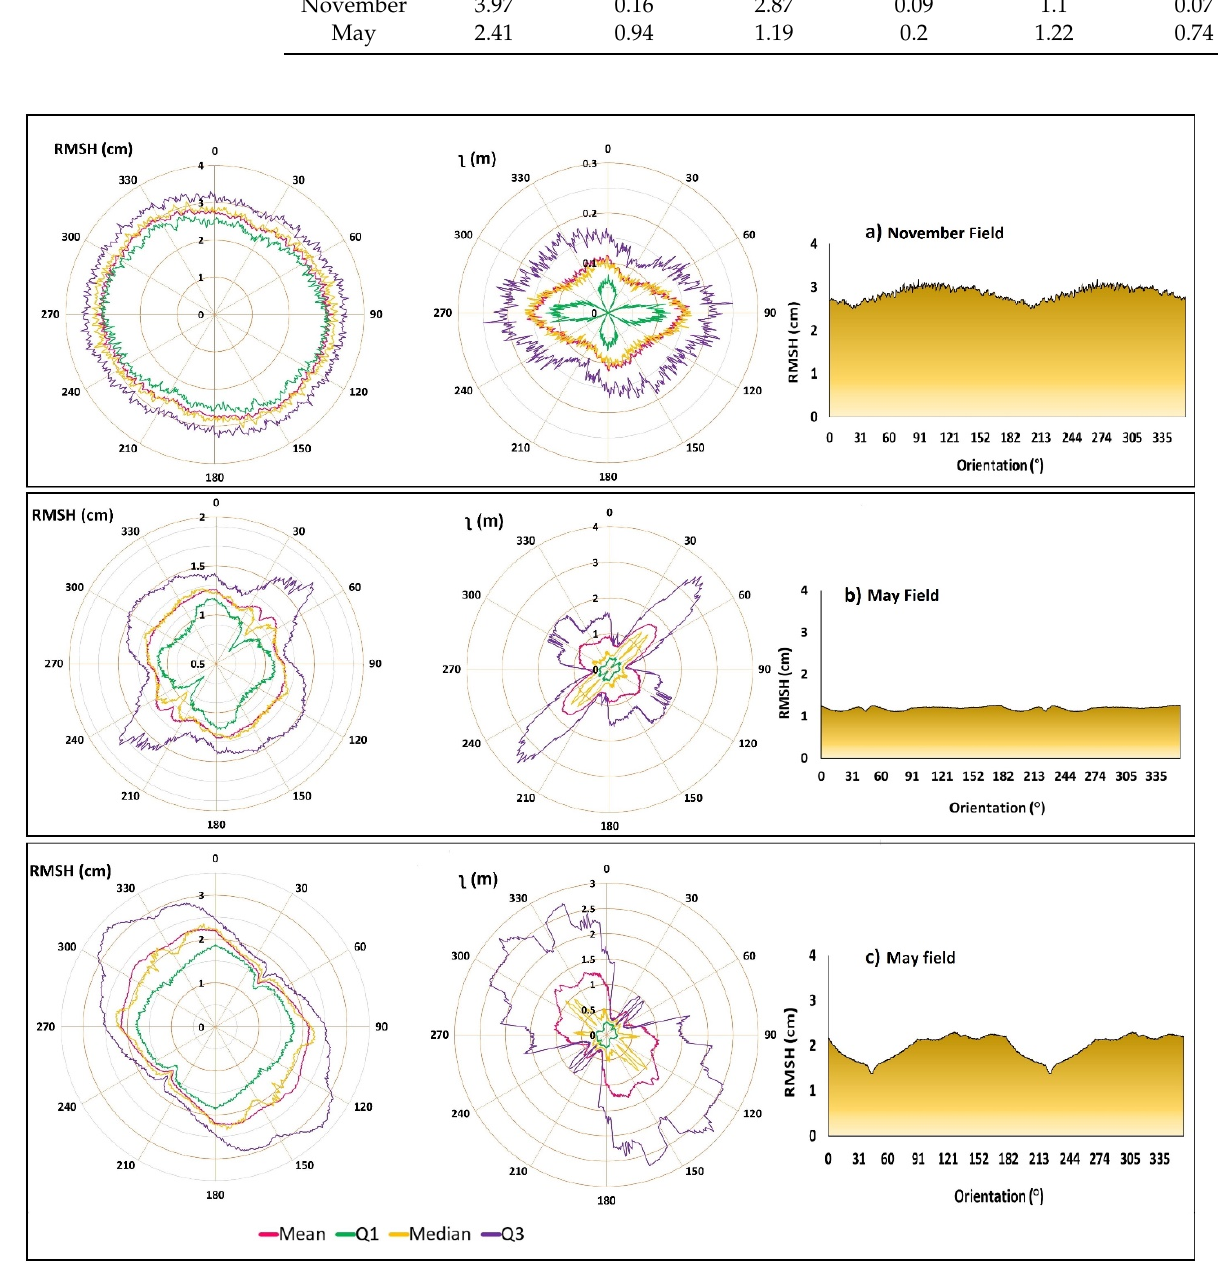
Figure 3. Variation of surface roughness characteristics across orientations for three representative fields (Figure 3a–c). ( a ) A homogenous field with low variations in RMSH and correlation length in the whole field. ( b ) A moderately smooth field with some distinct variability across some orientations and more ridges and furrows than field Figure 3a. ( c ) A rough field with the highest variability of RMSH and correlation length and more distinct ridges and furrows across orientations.